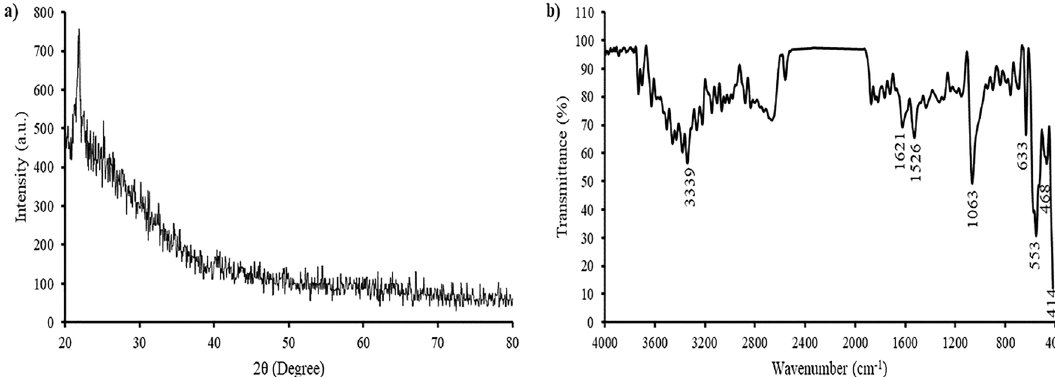
Figure 5. XRD pattern ( a ) and FTIR analyses ( b ) of biosynthesized